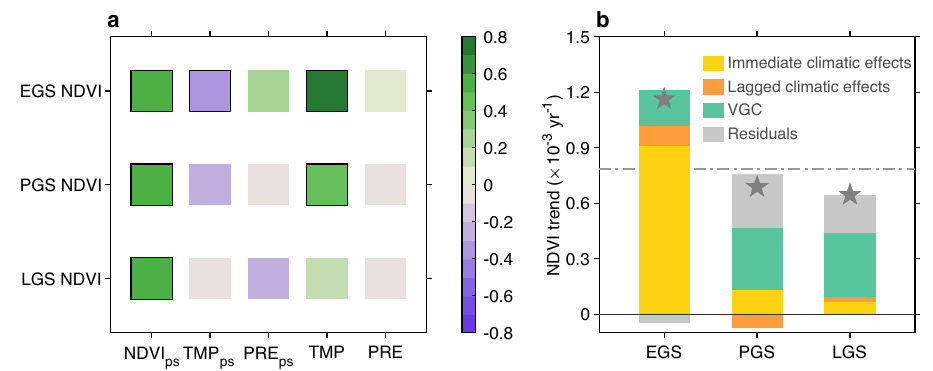
Fig. 1 Satellite-based vegetation growth carryover versus climatic effects. a Partial correlation coef fi cients between 35-year seasonal Normalized Difference Vegetation Index (NDVI) time series and concurrent climatic factors (temperature, TMP and precipitation, PRE), and climatic factors (TMP ps and PRE ps ) and NDVI (NDVI ps ) of the preceding season. The subscript ps denotes values for the immediately preceding season, except that ps for early growing-season (EGS) NDVI refers to NDVI of the preceding late growing season (LGS). Squares with black outline show statistically signi fi cant correlations at the 95% con fi dence level. b Individual contributions of the vegetation growth carryover (VGC) effect and the immediate and lagged climatic effects to seasonal NDVI trends over the 35 years (1982 – 2016) (see “ Methods ” ). The gray dashed line indicates the observed trend of the growing-season mean NDVI over the Northern Hemisphere, and the gray stars indicate the observed NDVI trend of